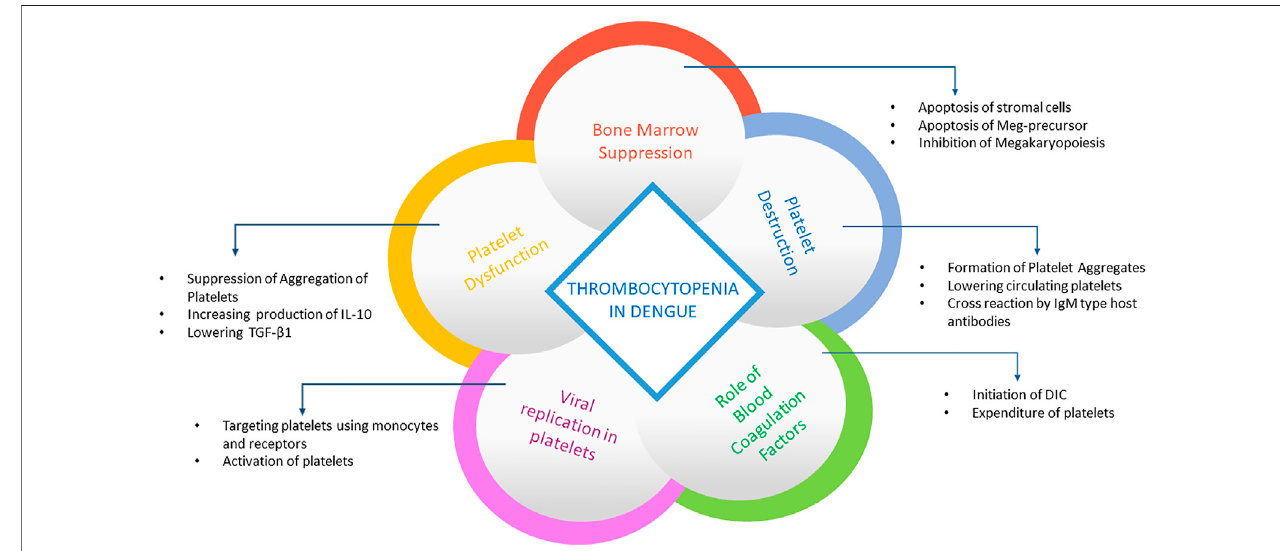
FIGURE 5 | Summary of processes behind thrombocytopenia in dengue. The panel summarizes how platelets are destroyed after dengue infection. After viral replication in platelets, it activates platelets using receptors and monocytes as well as aggregates the platelets, reducing its availability. It also suppresses bone marrow and prevents platelet formation by destroying premature